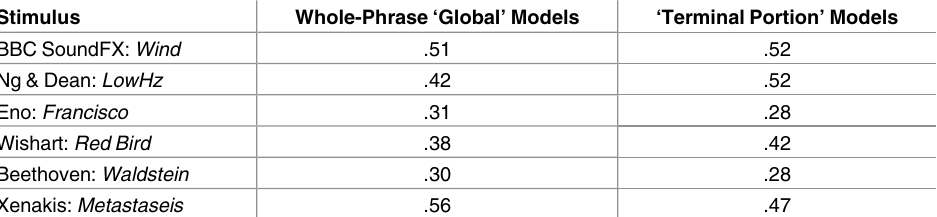
Table 5. Comparison of R 2 values between whole-phrase ‘global’ models and ‘terminal portion’ models.